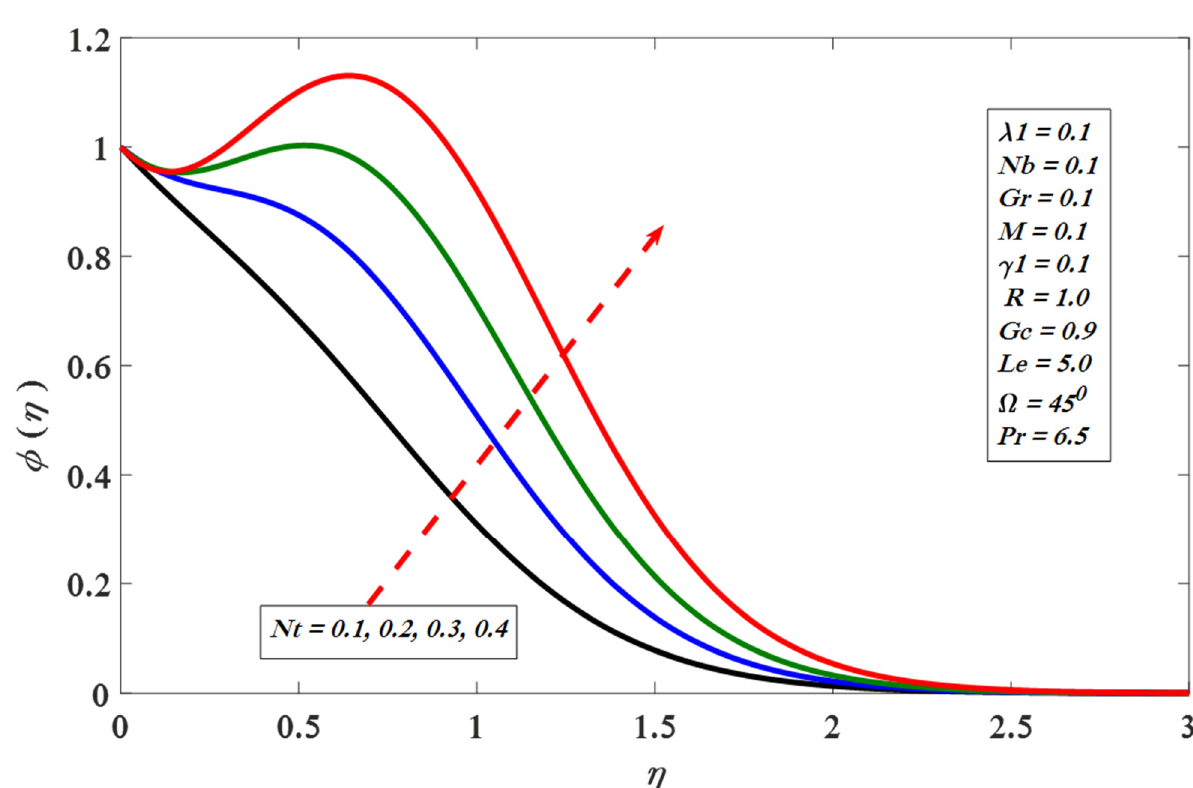
Figure 15. Concentration profile versus Nb .